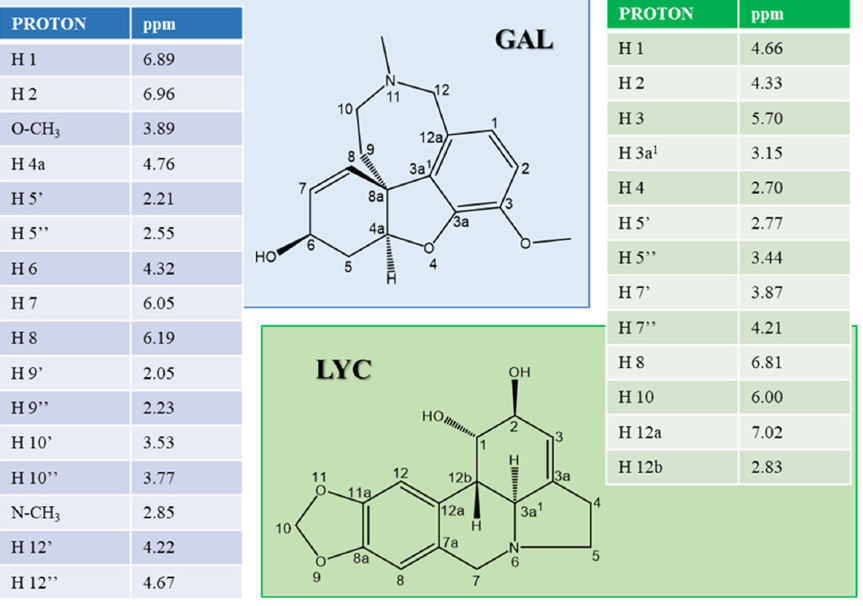
Figure 1. 1 H chemical shift values (ppm) of GAL (left) and LYC (right) protons. NMR 1D spectra were recorded on a solution of alkaloid 0.25 mM in 20 mM phosphate buffer, pH 7.5, T = 298